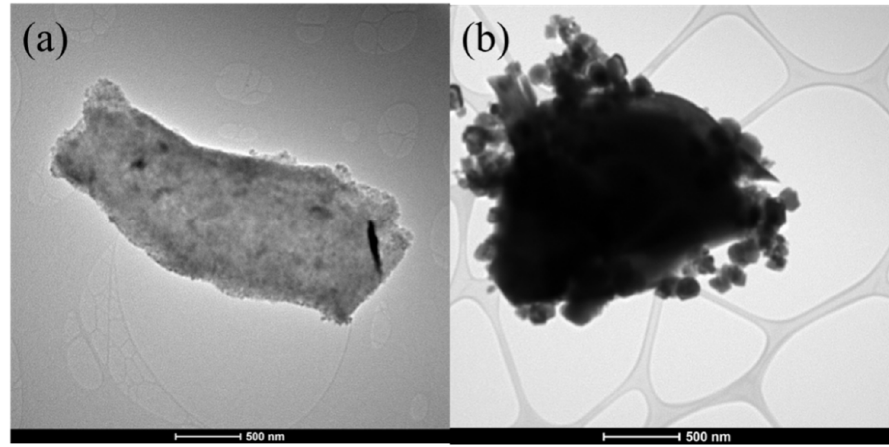
Figure 12. TEM Micrograph of ( a ) MXene, and ( b ) MXene/ Fe 3 O 4 .